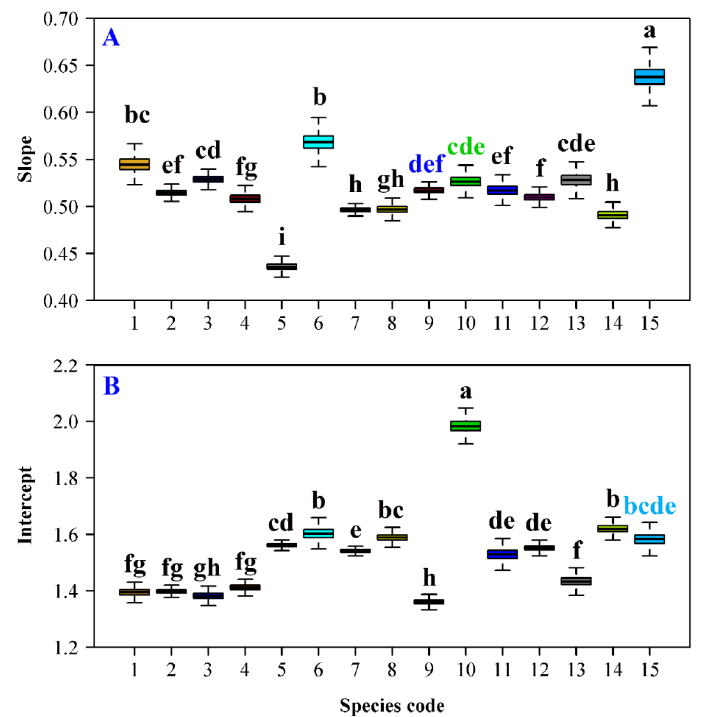
Figure 6. Boxplots of the slope ( A ) and intercept ( B ) for a linearized equation of the scaling relationship between ln(leaf perimeter) and ln(leaf area) (see Figure 5 for details). Different colors represent different species of vines.